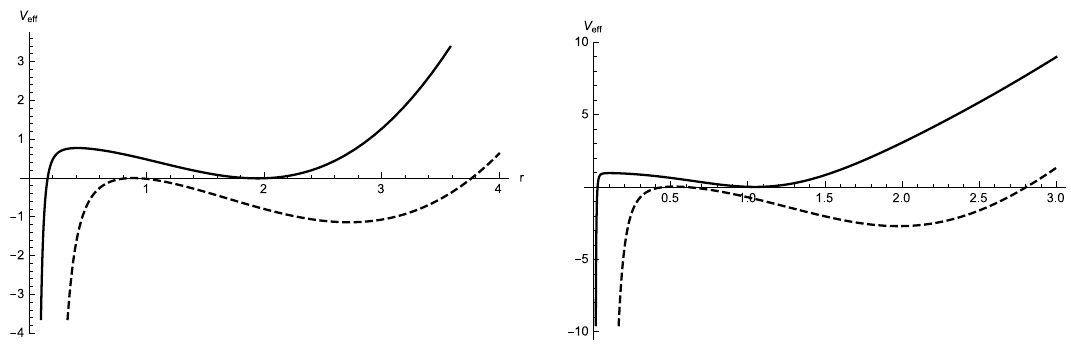
Figure 2 . The limiting cases within which oscillatory shell motion exists. The plot on the left corresponds to (cid:13) = 2, (cid:11) = (cid:0) 0 : 4, m = 0 : 94, M = 0 : 006 (dashed) and m = 0 : 1, M = 0 : 012 (solid). The plot on the right corresponds to (cid:13) = 3, (cid:11) = (cid:0) 0 : 05, m = 0 : 5, M = 0 : 002 (dashed) and m = 0 : 004, M = 0 : 026 (solid). The two plots indicate that increasing (cid:13) brings the two limiting cases closer to each